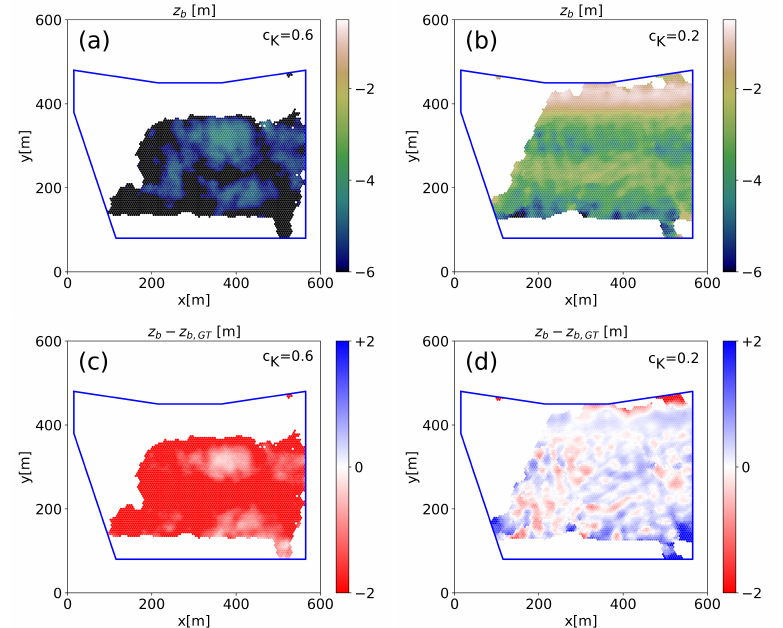
Figure 13. Bathymetry ( top , ( a , b )) and errors ( bottom , ( c , d )) obtained without RANSAC for c K = 0.6 ( left , ( a , c )) and c K = 0.2 ( right , ( b , d